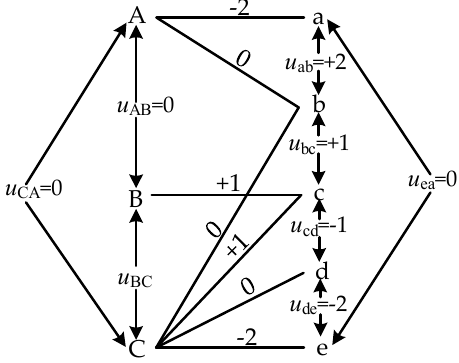
Figure 3. Vector combination of V i0 – V o1 .